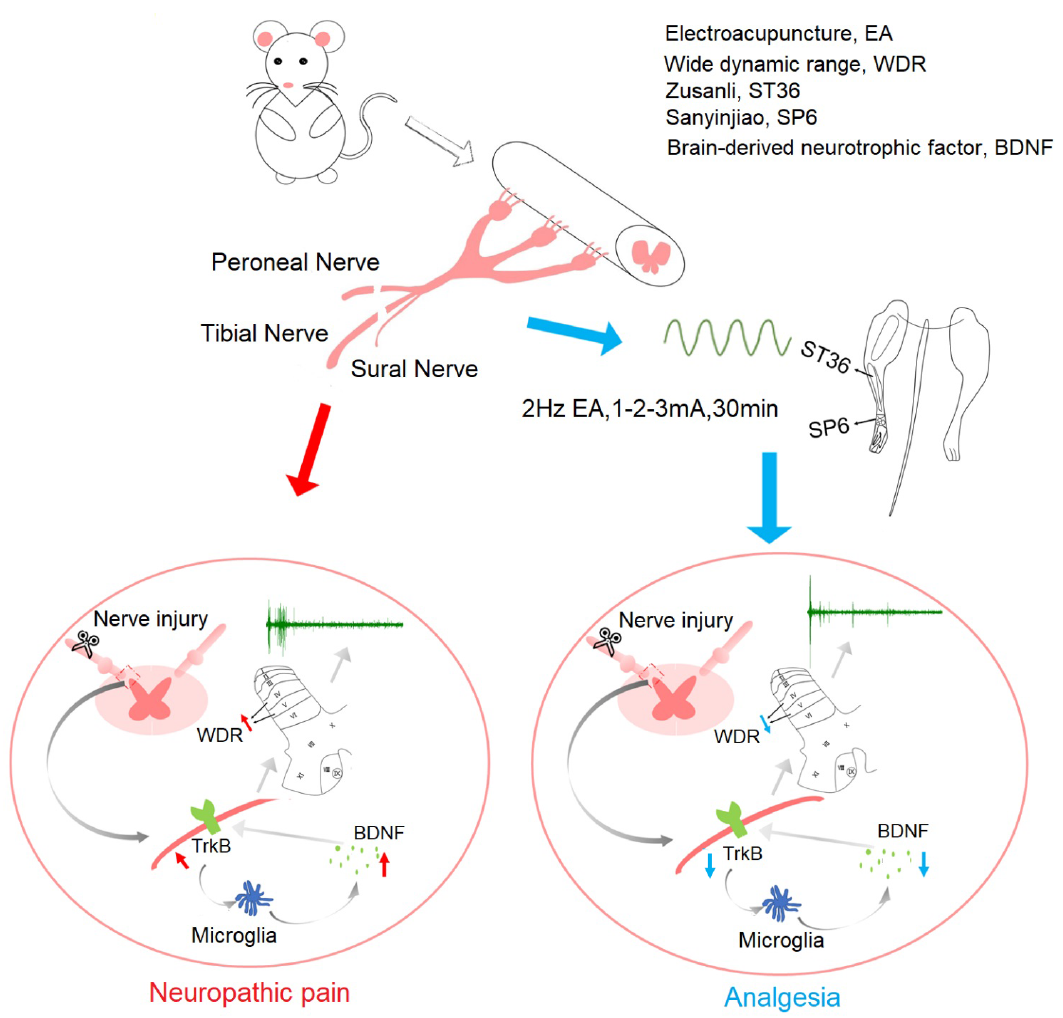
Figure 9. Schematic diagram illustrating the potential mechanisms underlying 2 Hz EA-mediated analgesic e ff ect on SNI-induced neuropathic pain. Administration of 2 Hz EA to SNI